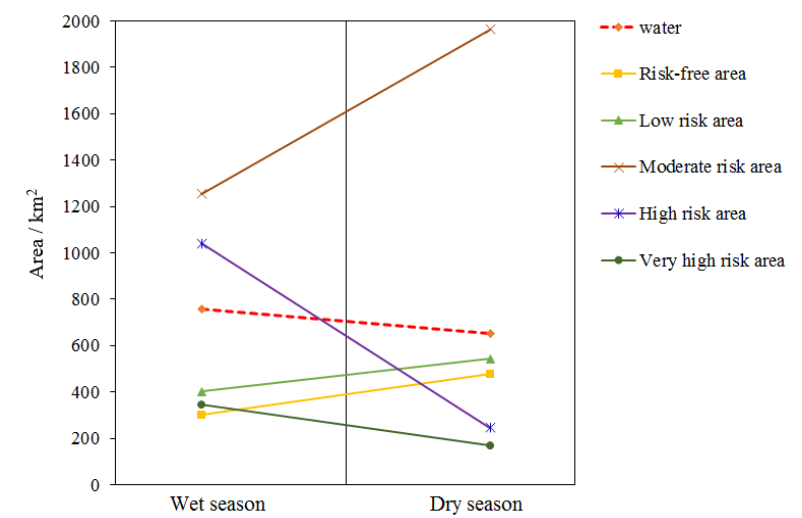
Figure 11. Relationship between lake water volume and soil salinization risk transfer.